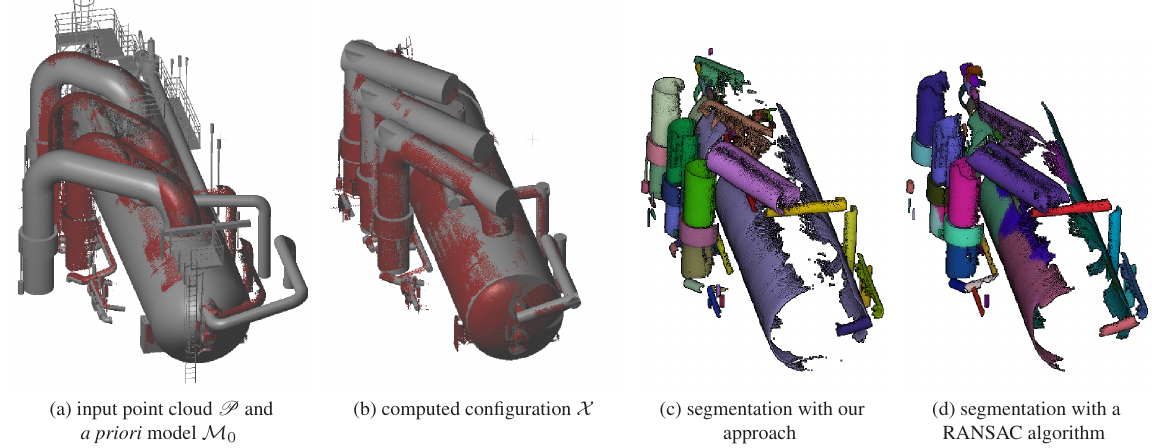
Figure 1: Reconstruction results on an industrial dataset. The a priori 3D model (grey in Figure (a)) has 626 shapes, among which there are 391 cylinders, and presents some obvious differences with respect to the point cloud (red: 990323 points). Most of the cylinders in the a priori model are not present in the point cloud. The computed configuration (grey in Figure (b)) has 68 cylinders, and the corresponding segmentation is shown in Figure (c): each segment is displayed with its own random color. These results can be compared with the segmentation provided by the algorithm of (Schnabel et al., 2007) shown in Figure